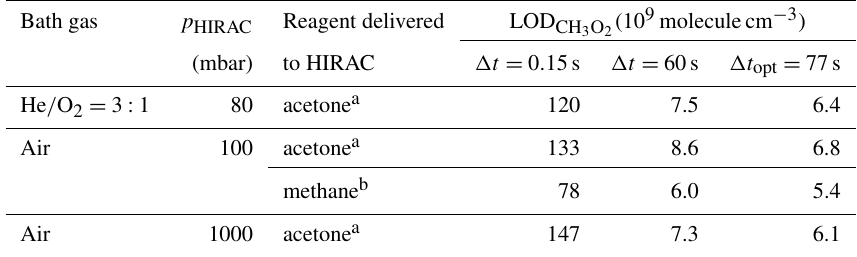
Table 2. CRDS detection limits for CH 3 O 2 calculated at 80mbar He / O 2 = 3 : 1 and 100 and 1000mbar of synthetic air for single ring-down measurements ( (cid:49)t = 0 . 15s), the optimum averaging time obtained from Allan–Werle deviation plot (Fig. 5 shows an example), (cid:49)t opt . (77s under all experimental conditions) and (cid:49)t =